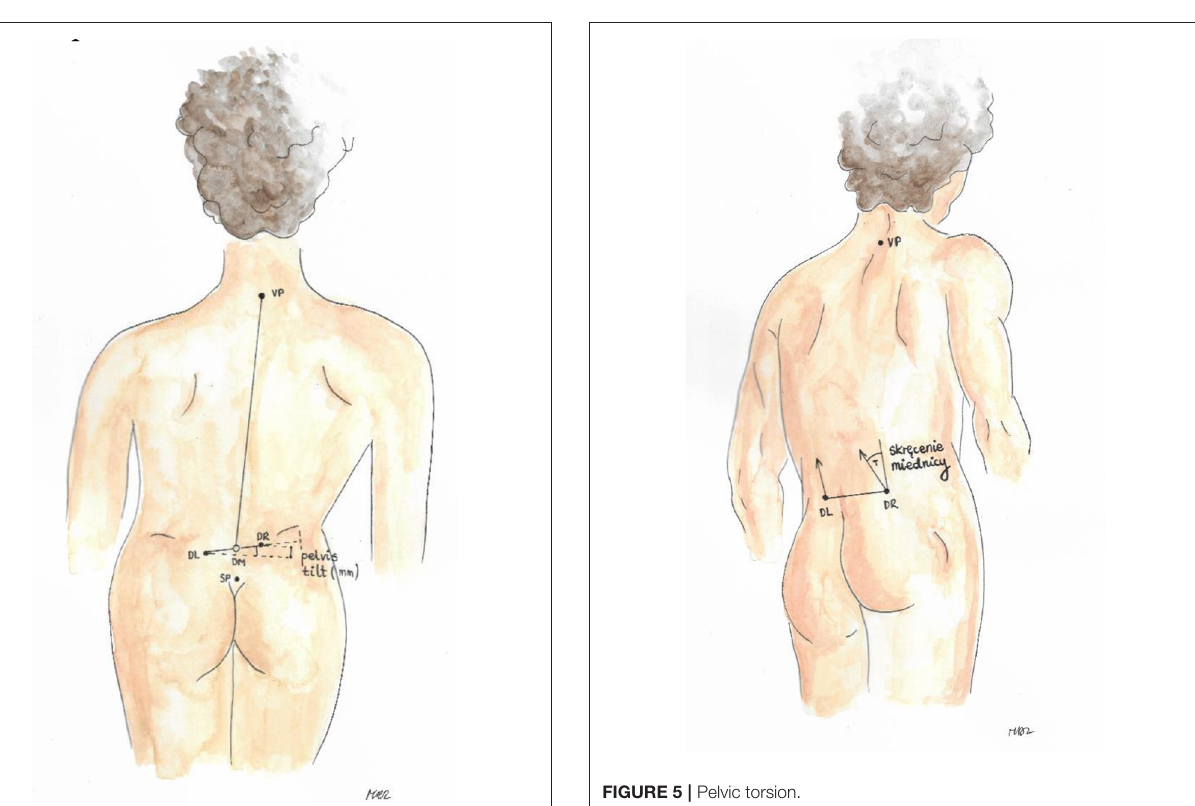
FIGURE 5 | Pelvic